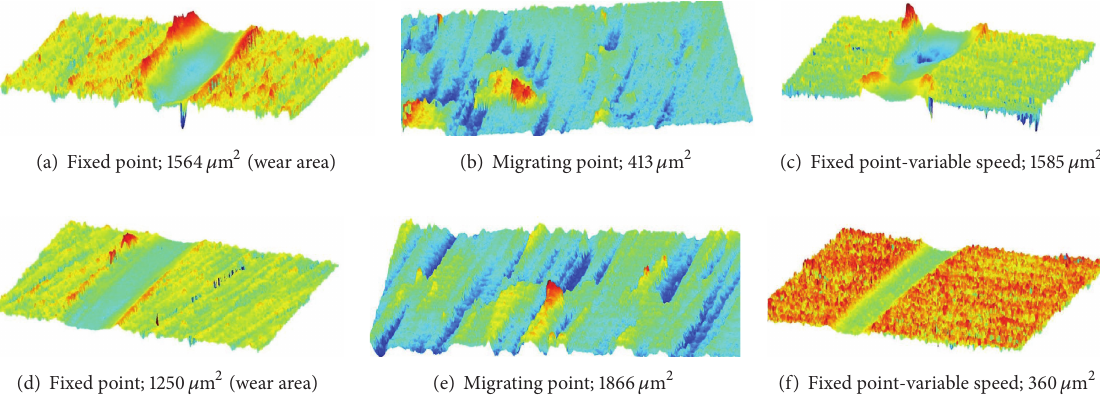
Figure 4: Surface topography images (2 mm × 2 mm) of the wear tracks on the disk lubricated by the motor oil 5W30 or 5W40. (a, d) fixed point condition and circular geometry, (b, e) migrating point condition and spiral geometry, and (c, f) fixed point-variable speed condition and circular